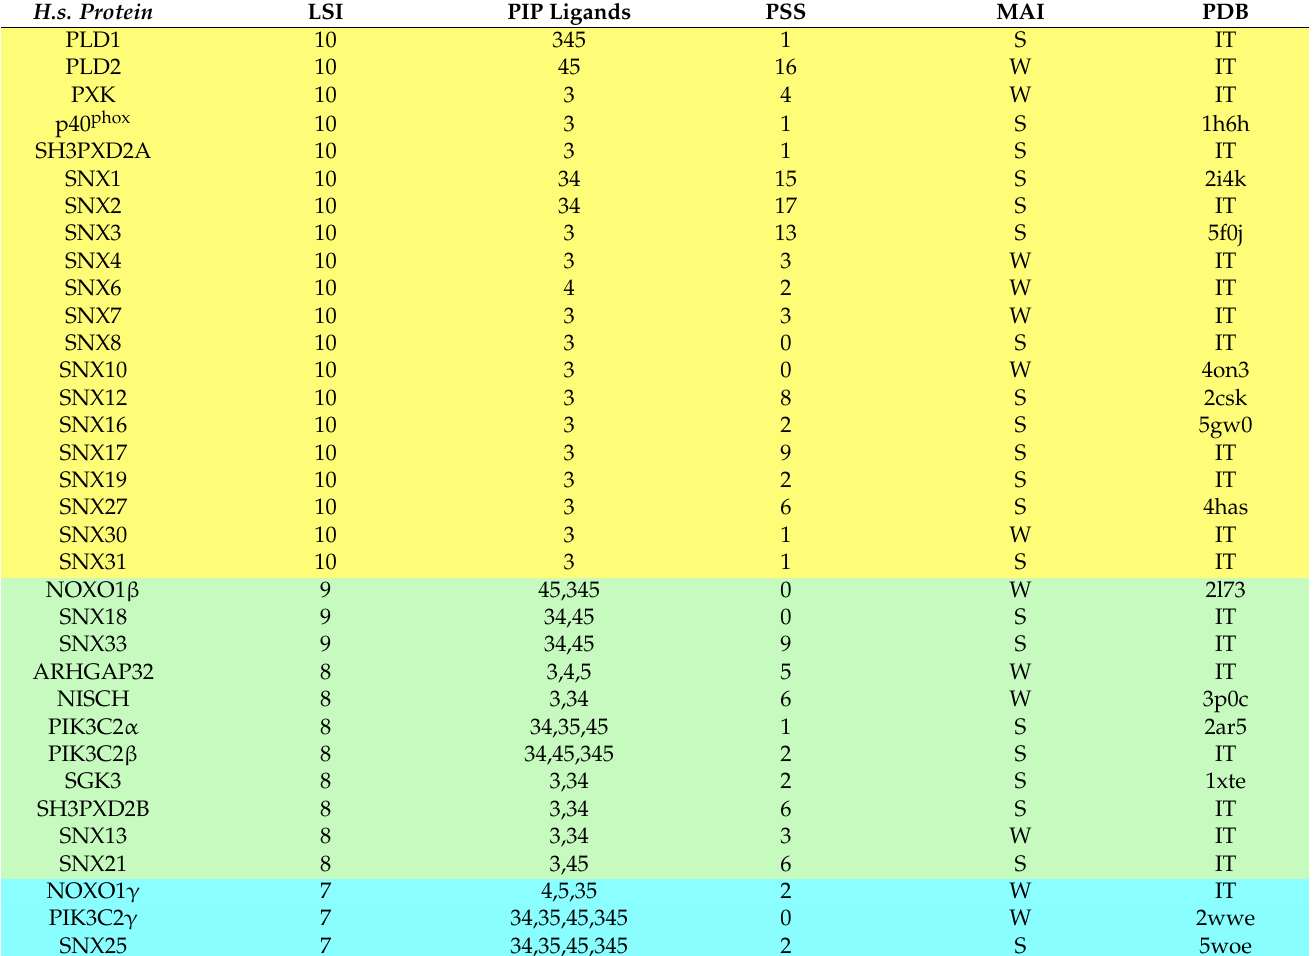
Table 1. Properties of PX domains